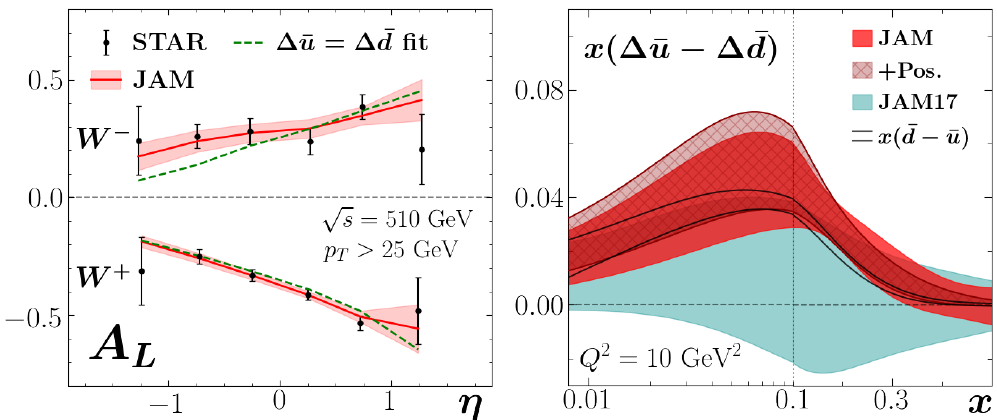
± Figure 1: Left panel : Single-spin asymmetries A W from STAR [ 8 ] (black circles) L compared with the full JAM fit (red solid lines and bands) and with a fit where ∆ ¯ u is set equal to ∆ ¯ d (green dashed lines). Right panel : Result from this analysis (JAM) for the helicity sea asymmetry x ( ∆ ¯ u − ∆ ¯ d ) (red bands) at Q 2 = 10 GeV 2 . The result is also shown with positivity constraints (red hatched bands) and is compared to the results from JAM17 [ 11 ] (cyan band) and the unpolarized asymmetry x ( ¯ d − ¯ u ) (black lines) (note the reversed sign). All bands and doubled lines represent 1 σ